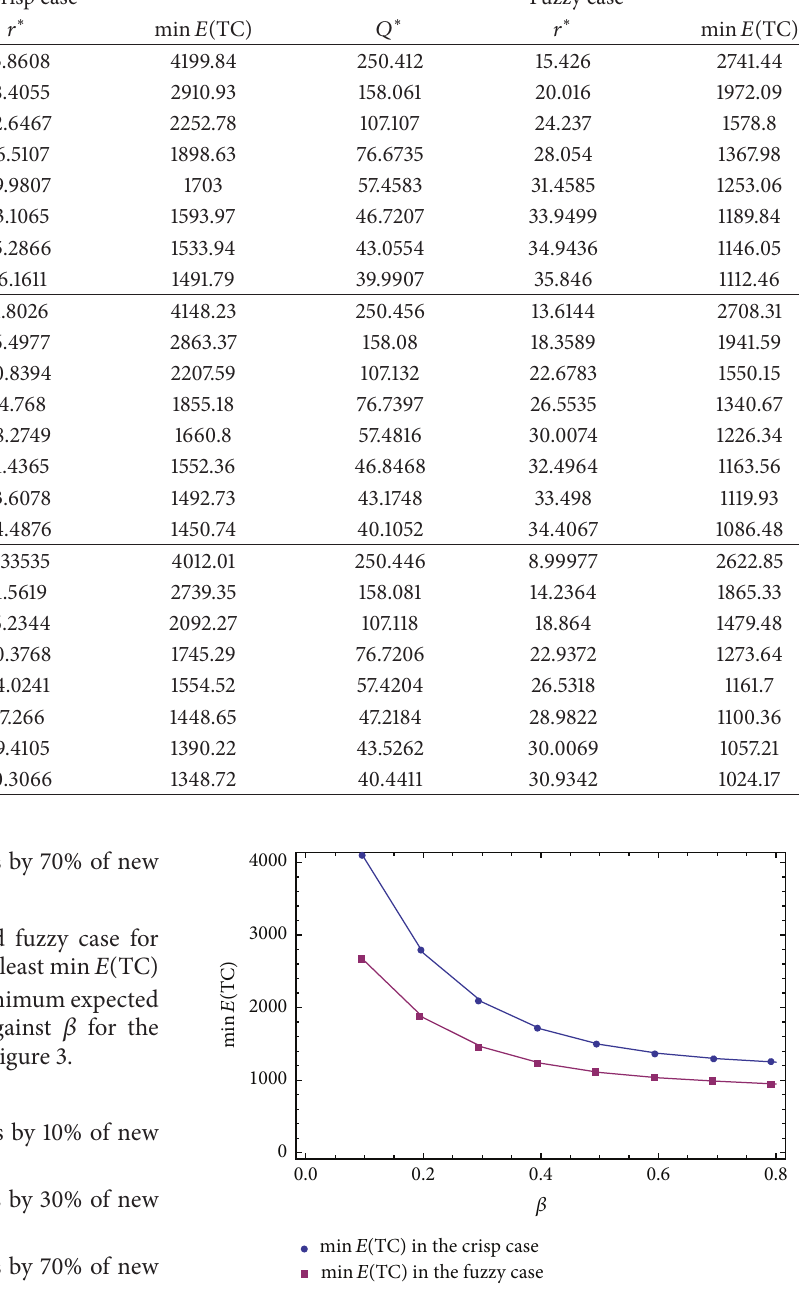
Figure 3: The comparison between the crisp and fuzzy cases for Laplace at 𝛾 = 0.7